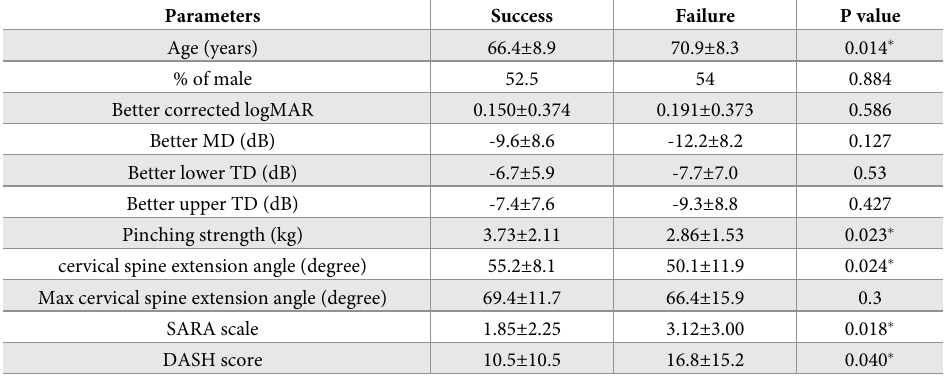
Table 2. Comparison of demographics and vision-related parameters between the instillation failure group and the success group.